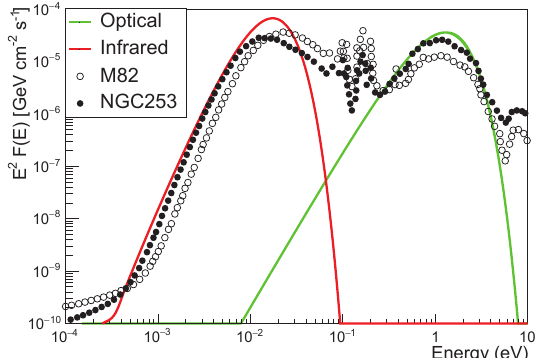
Figure 1. Photon spectrum of the prototype SBG, as inspired by [21]: thermal dust modified black bodies (red line) and optical star black body (green line). The black points refer to the mea- surements from [22] for two di ff erent SBG: M82 and